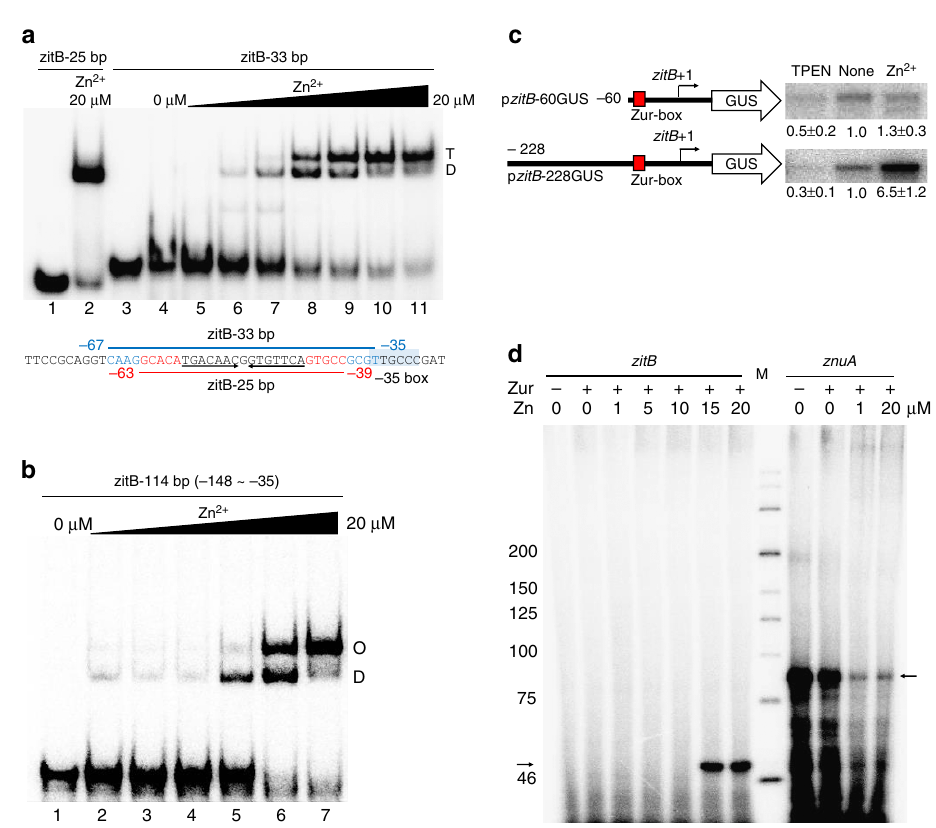
Figure 5 | Zinc-dependent formation of multimeric Zur- zitB DNA complexes in vitro and the contribution of Zur-box upstream region on zitB activation in vivo . ( a ) EMSA analysis of Zur binding on 33bp zitB DNA probe in comparison with the complex on 25bp zitB DNA. Increasing amounts of zinc (0, 0.1, 0.5, 1.0, 2.5, 5, 10 and 20 m M) were included in the binding buffer with 90nM Zur. The molecular weights of the retarded bands were